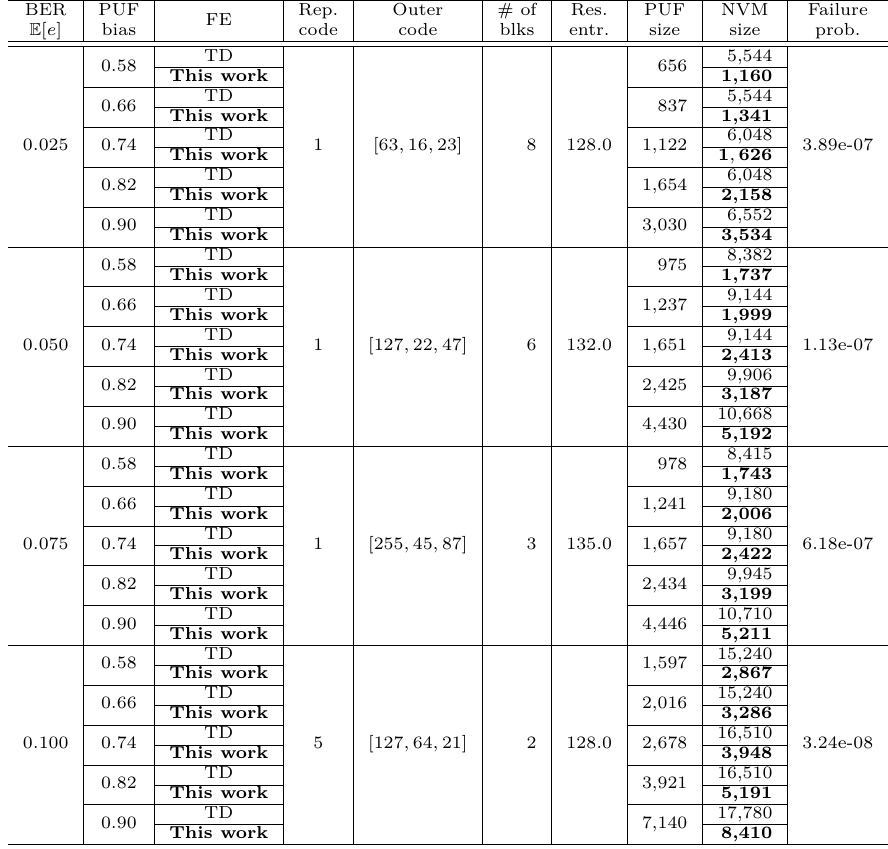
Table 11: Simulation results of 128-bit key generation using AR- and TD-based FEs BER PUF FE